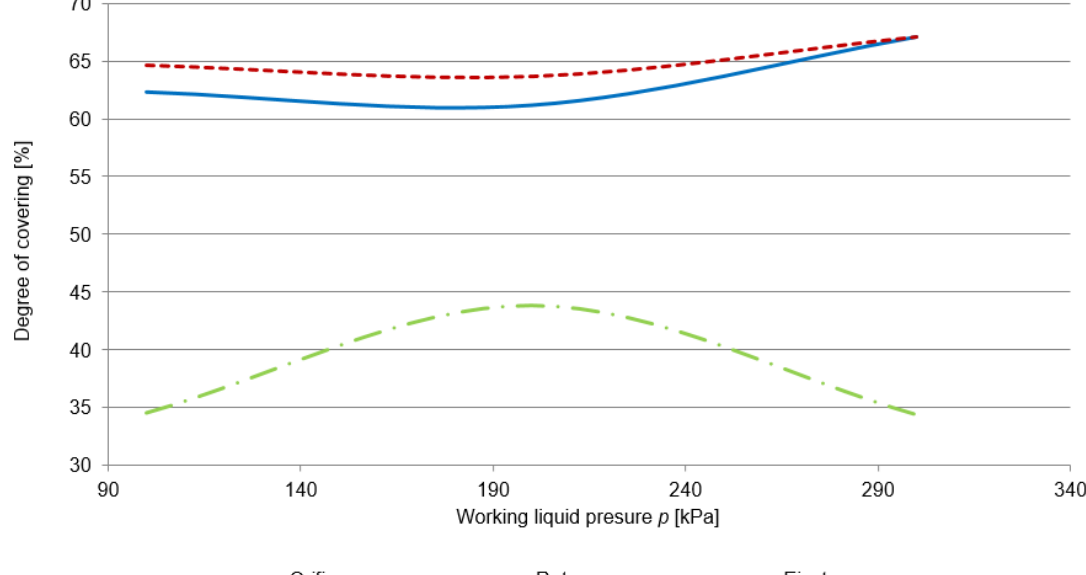
Figure 7. The degree of seed potato covering with the dressing substance for the electronically controlled sprayer valve with an additional supply of compressed air positioned at a distance S of 50 mm from the seed potato fall axis.